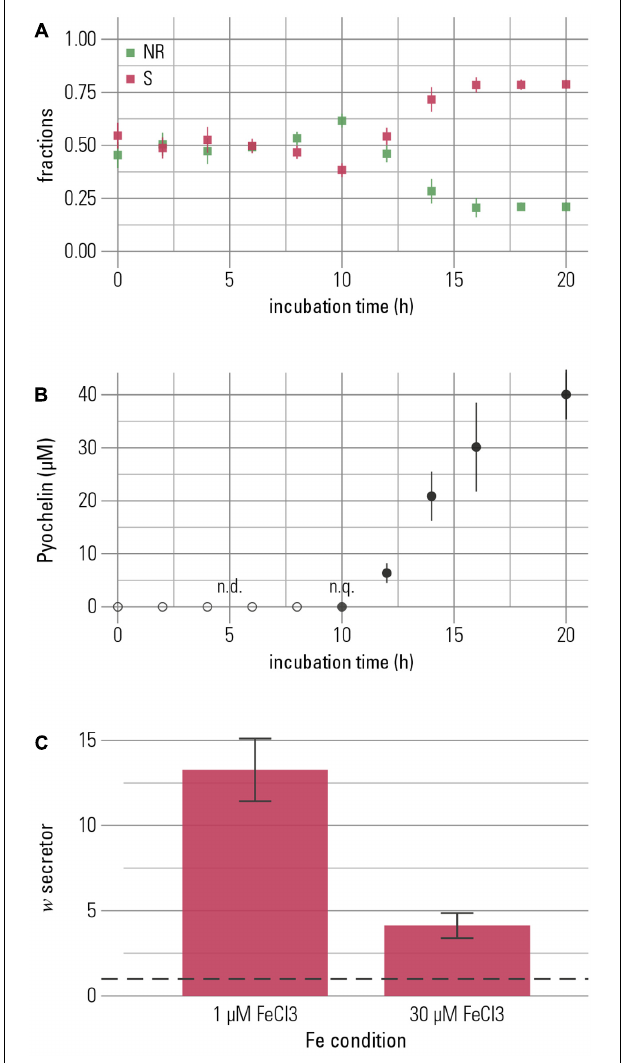
FIGURE 4 | The competitive advantage of the pyochelin-secretor is temporally linked to production of pyochelin. Secretor and non-recipient were grown in 1:1-competitions for 20 h. (A) The fractions of each competition partner are shown over time with the secretor (S) in red and the non-recipient (NR) in green. The frequency of the secretor increased after 12 h of growth. (B) Increase of the secretor was temporally associated with the production of pyochelin. Pyochelin was detectable in the supernatant after 10 h and accumulated in the medium over time. Means of three biological replicates are shown and error bars represent standard error of the mean (n.q. = non-quantifiable, below quantification limit of 1 µ M). (C) To quantify the overall outcome of competition, a proxy for relative fitness ( w , Ross Gillespie et al., 2007), was calculated. Neutral competition outcome, where w equals 1, is indicated by a dashed line, and w > 1 indicates higher fitness of the secretor. The secretor shows a higher fitness at both low and high iron concentrations (1 µ M FeCl 3 and 30 µ M FeCl 3 , respectively; Welch t -test with alternative hypothesis that true mean of w is greater than µ = 1: for 1 µ M FeCl 3 t = 6.67, p < 0.001, and for 30 µ M FeCl 3 t = 4.23, p = 0.002). Under iron-rich conditions, the increase of the secretor is smaller, though, than under iron-limitation (Wilcoxon rank sum test, W = 60.5, p = 0.003). This outcome is robust to the identity of the combination of strain and fluorescent protein (see Supplementary Figure S2). The bar chart shows the mean of eight repeats and error bars represent the standard error of the